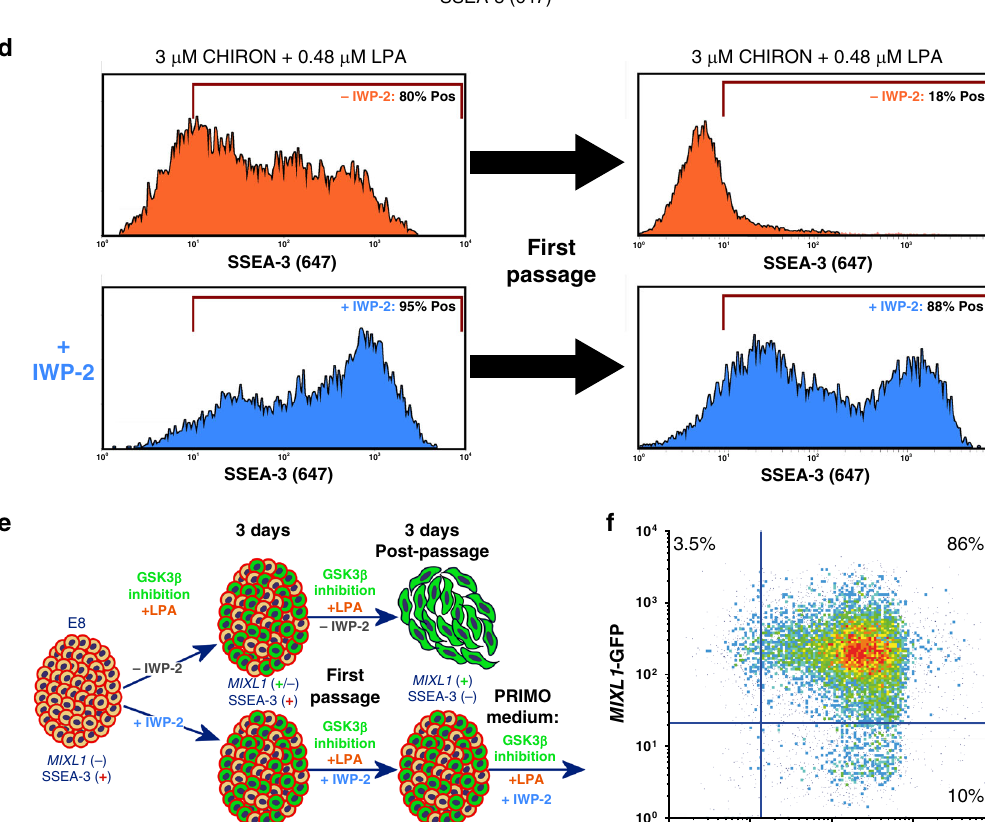
fraction from PRIMO conditions did not correlate with the zero hour, MIXL1- GFP( − )/SSEA-3( + ) cells from E8 but rather mapped on the trajectory between 12 and 18 h of differentiation (Fig. 4d). Thus, the PRIMO medium appears to trap all cells in an intermediate substate but, interestingly, this substate appears to be independent of MIXL1 -GFP reporter expression. Differential gene expression analysis by DESeq2 and SeqMonk of cells growing in PRIMO, pooling data from both MIXL1- GFP( + )